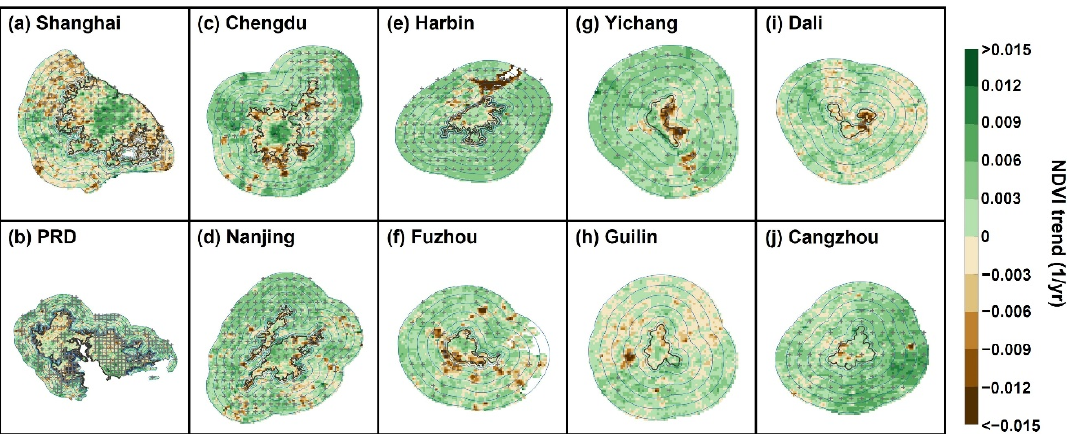
Figure 7. Spatial pattern of NDVI trends across different cities from 2000–2020. The ten cities are representative of different sizes, e.g., megacities (Shanghai, and PRD), megapolis (Chengdu, and Nanjing), big cities (Harbin, and Fuzhou), mid-sized cities (Yichang, and Guilin), and small cities (Dali, and Cangzhou). The cross-shaped portion illustrate the trends statistically significant at the 5% levels. The black line is the boundary of the city, and the grey line is the boundary of the buffer